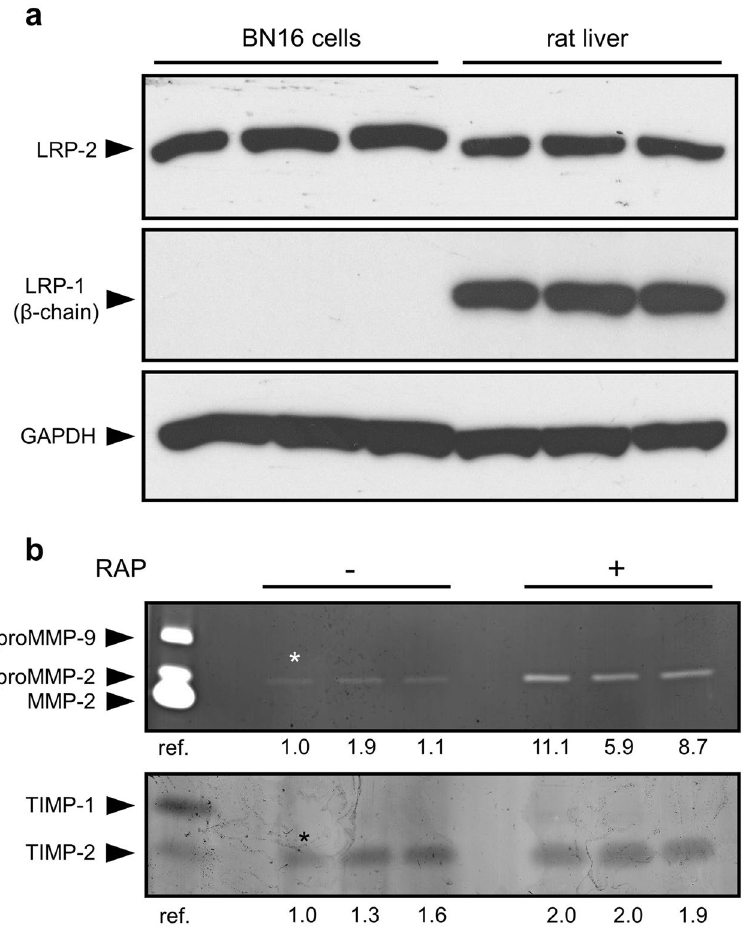
Figure 1. Expression of functional megalin/LRP-2 but not LRP-1 in BN16 cells. ( a ) Expression of megalin/ LRP-2 and LRP-1 was evaluated by western blot analysis in BN16 cell extracts (50 μ g protein). As positive control, receptor expression was determined in tissue extracts (50 μ g protein) from rat liver 40 . Images were cropped for presentation. Additional data without cropping are presented in Supplementary Fig. 1. ( b ) Analysis of media conditioned by BN16 cells in the presence of the LRP competitor, RAP. BN16 cells were cultured for 24 h in serum-free DMEM in the absence or presence of 1 μ M RAP. Conditioned media were then collected, and total cell protein was measured using bicinchoninic acid microassay. Top panel, gelatin zymogram of medium conditioned by the equivalent of 5 μ g of cell protein. Bottom panel, reverse gelatin zymogram of medium conditioned by the equivalent of 10 μ g of cell protein. Representative results of three independent experiments. Reference (ref.) corresponds to medium conditioned by mouse calvarium, as previously reported 41 . Values under the gels indicate the fold-increase by comparison with the first non-treated sample ( * ). Band area and intensity were measured by using IMAGEJ image analysis